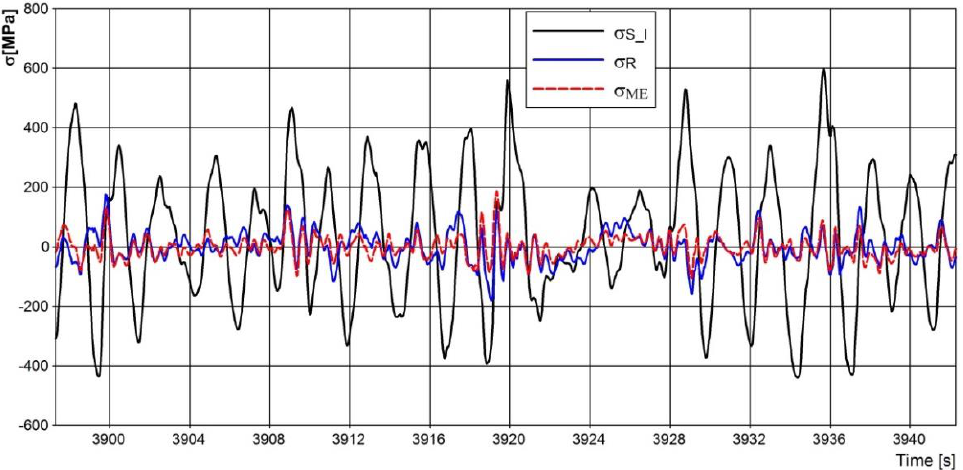
Figure 15. Stress distribution in leaf springs. Table 2. Estimated degrees of leaf spring durability increase when using a material with different fatigue characteristics compared to the base material ( k *= 4.4 = k